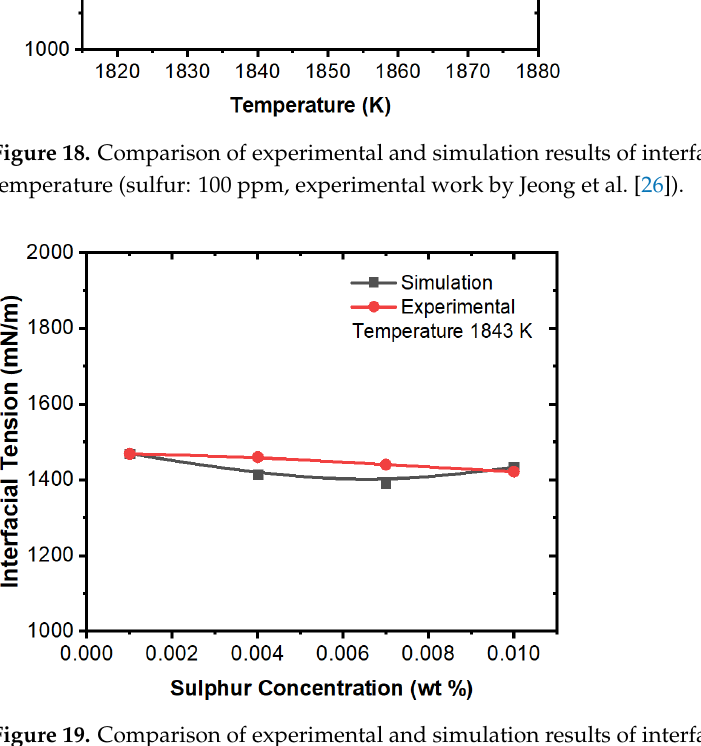
Figure 20. Comparison of experimental and simulation results of interfacial tension with respect to sulfur concentration (temperature 1873 K, experimental work by Jeong et al. [26]). Figures 19 and 20 show effect of sulfur concentration on interfacial tension at certain temperatures. It can be noted here that an increase in sulfur concentration has opposite impact on interfacial tension between alumina inclusions and molten steel. This also evi- dent from the experimental work of Jeong et al. [26]. Further, it was also reported that sulfur may preferentially concentrate near the interface during solidification, resulting in a concentration differential in the boundary layer. This phenomenon is also evident from the numerical results that a surfactant concentration gradient existed near the boundary layer and a higher amount of inclusion particles moved towards the solidifying boundary. Lastly, it can be correlated here that in this simulation, the alumina inclusions encounter lower interfacial tension from the solidifying boundary. Thus, it can be entrapped under these conditions. Finally, in practical situations, dendrites were formed at the solid–liquid boundary, and thus alumina inclusions may be caught between the dendrite arms. 4. Conclusions A numerical model was developed to study alumina inclusion motion behavior in continuous casting molds. We investigated inclusion motion under the influence of inter- facial tension in small domains of solidifying steel. For this purpose, we used a two-phase